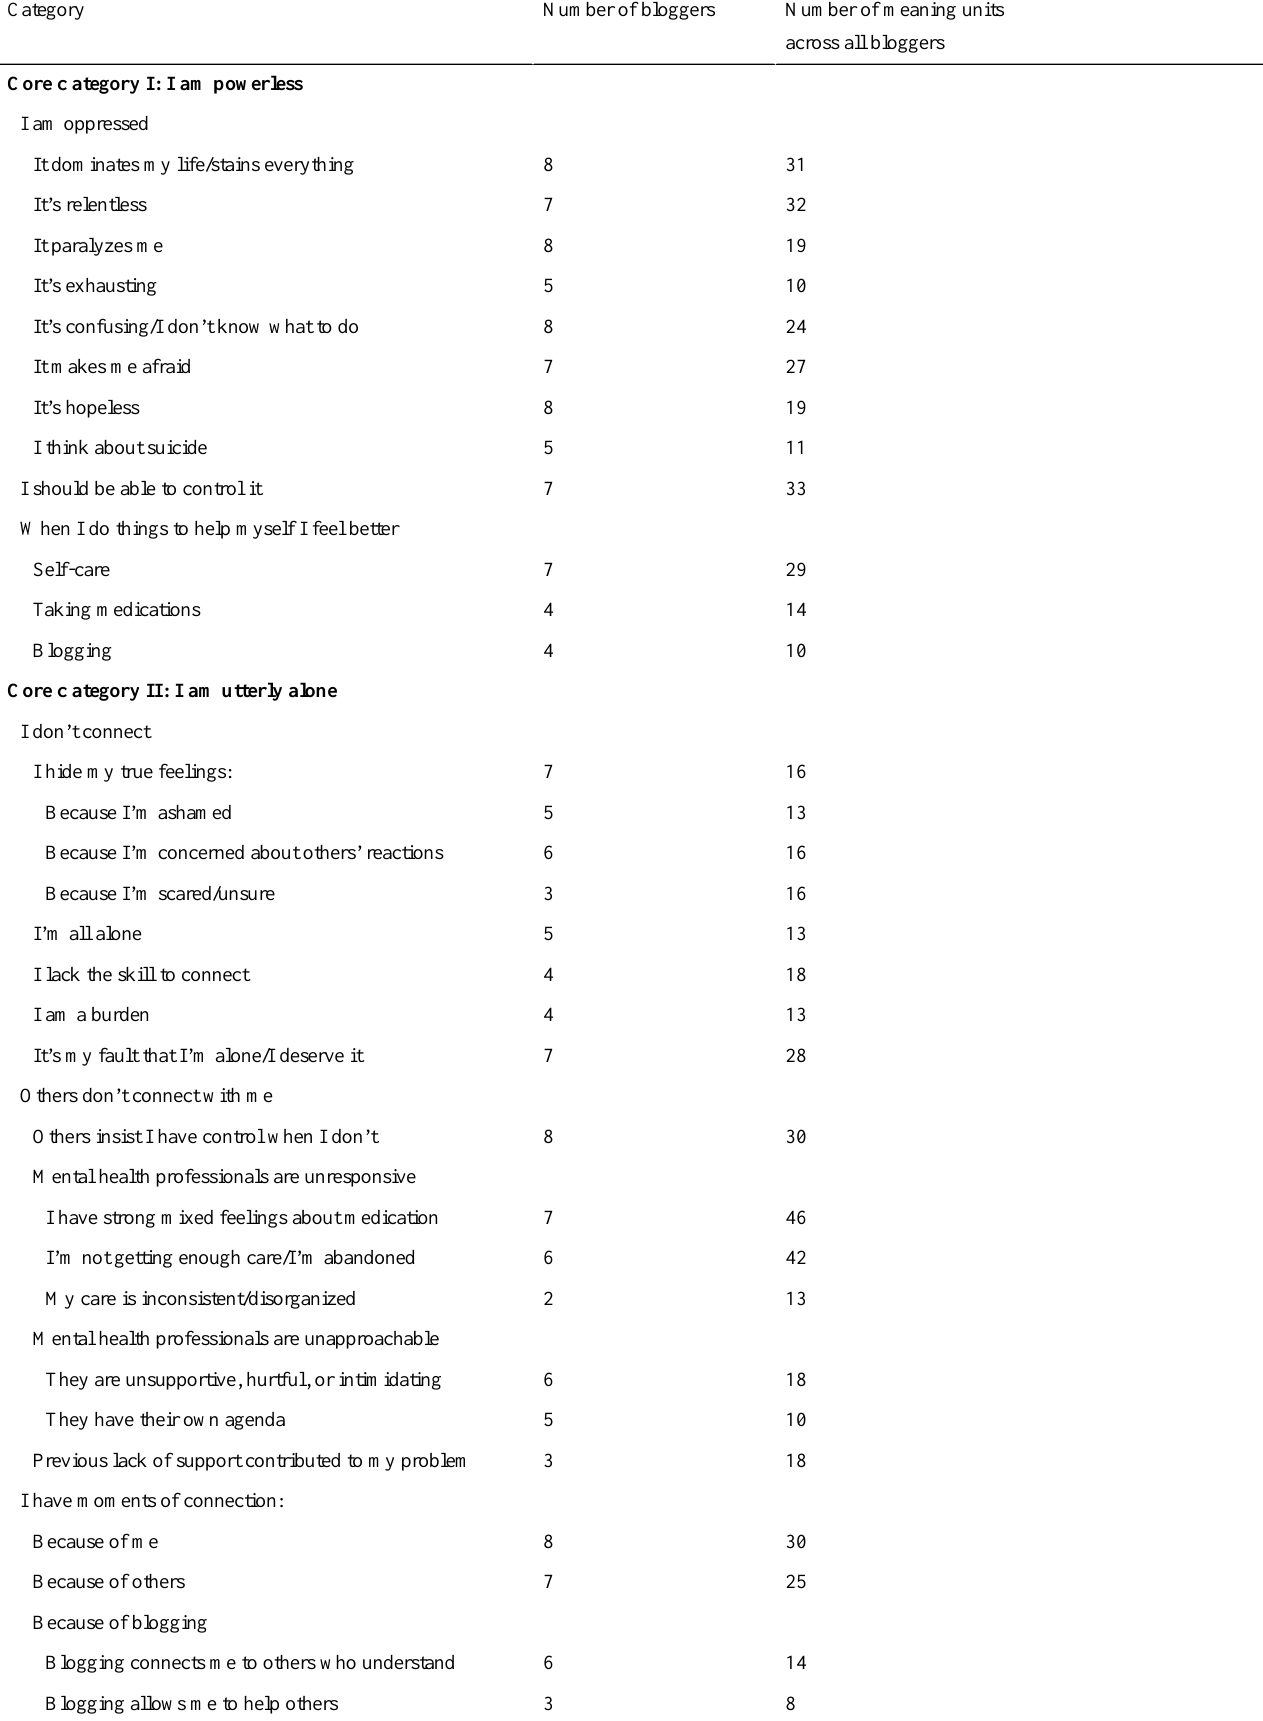
Table 3. Model of bloggers’experience of a mental health